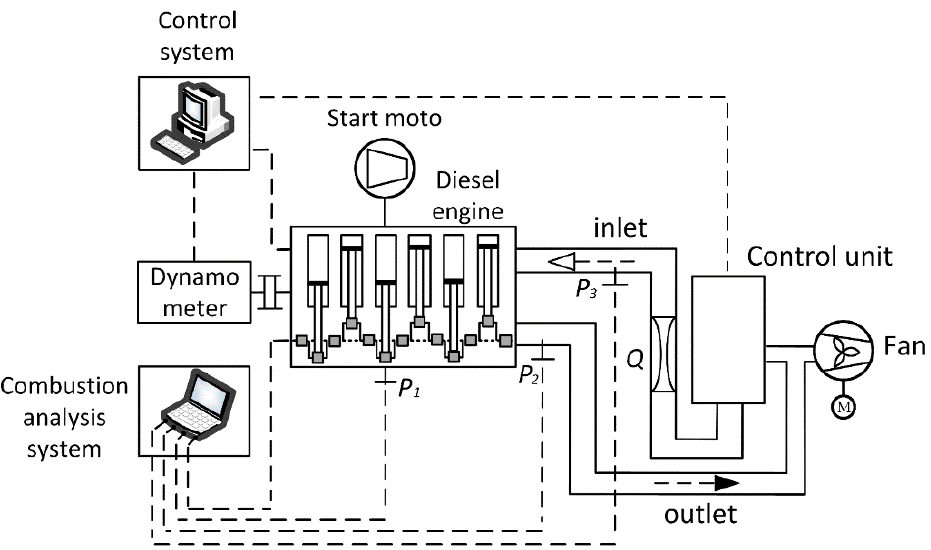
Figure 2. Schematic diagram of bench test.